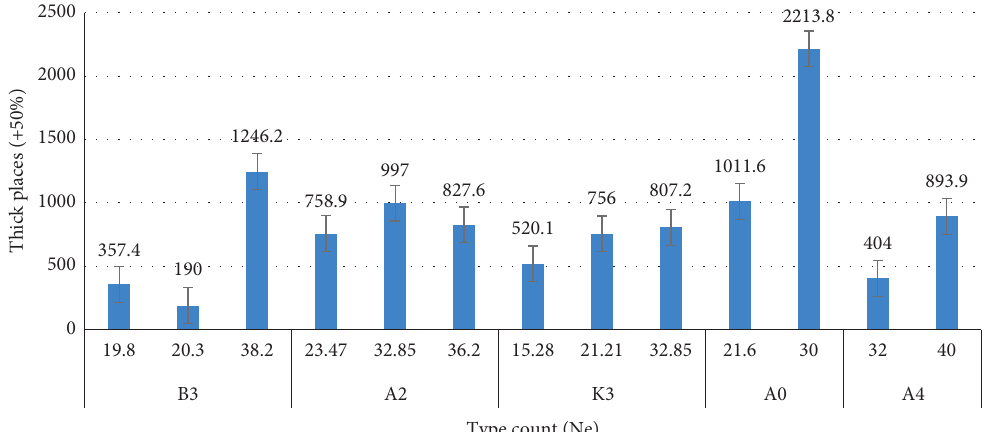
Figure 3: Yarn thick place